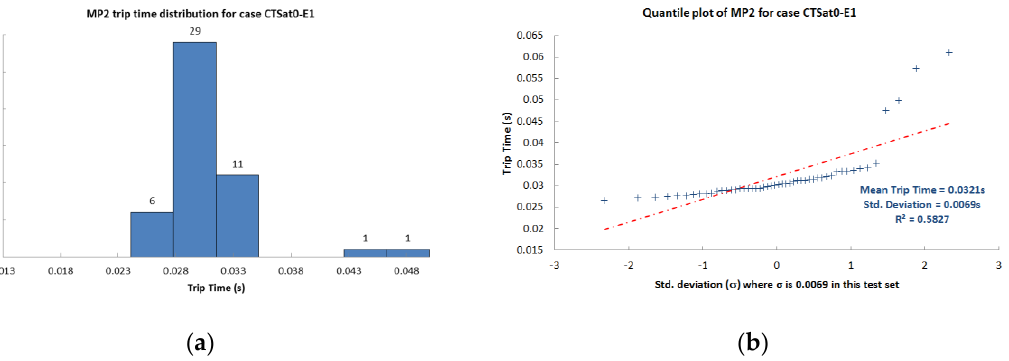
Figure 25. MP2 trip time distributions and quantile plot for case CTSat0-E1 (ideal CT, 1 faulty AMU, 3Ph-G fault at 50% of the